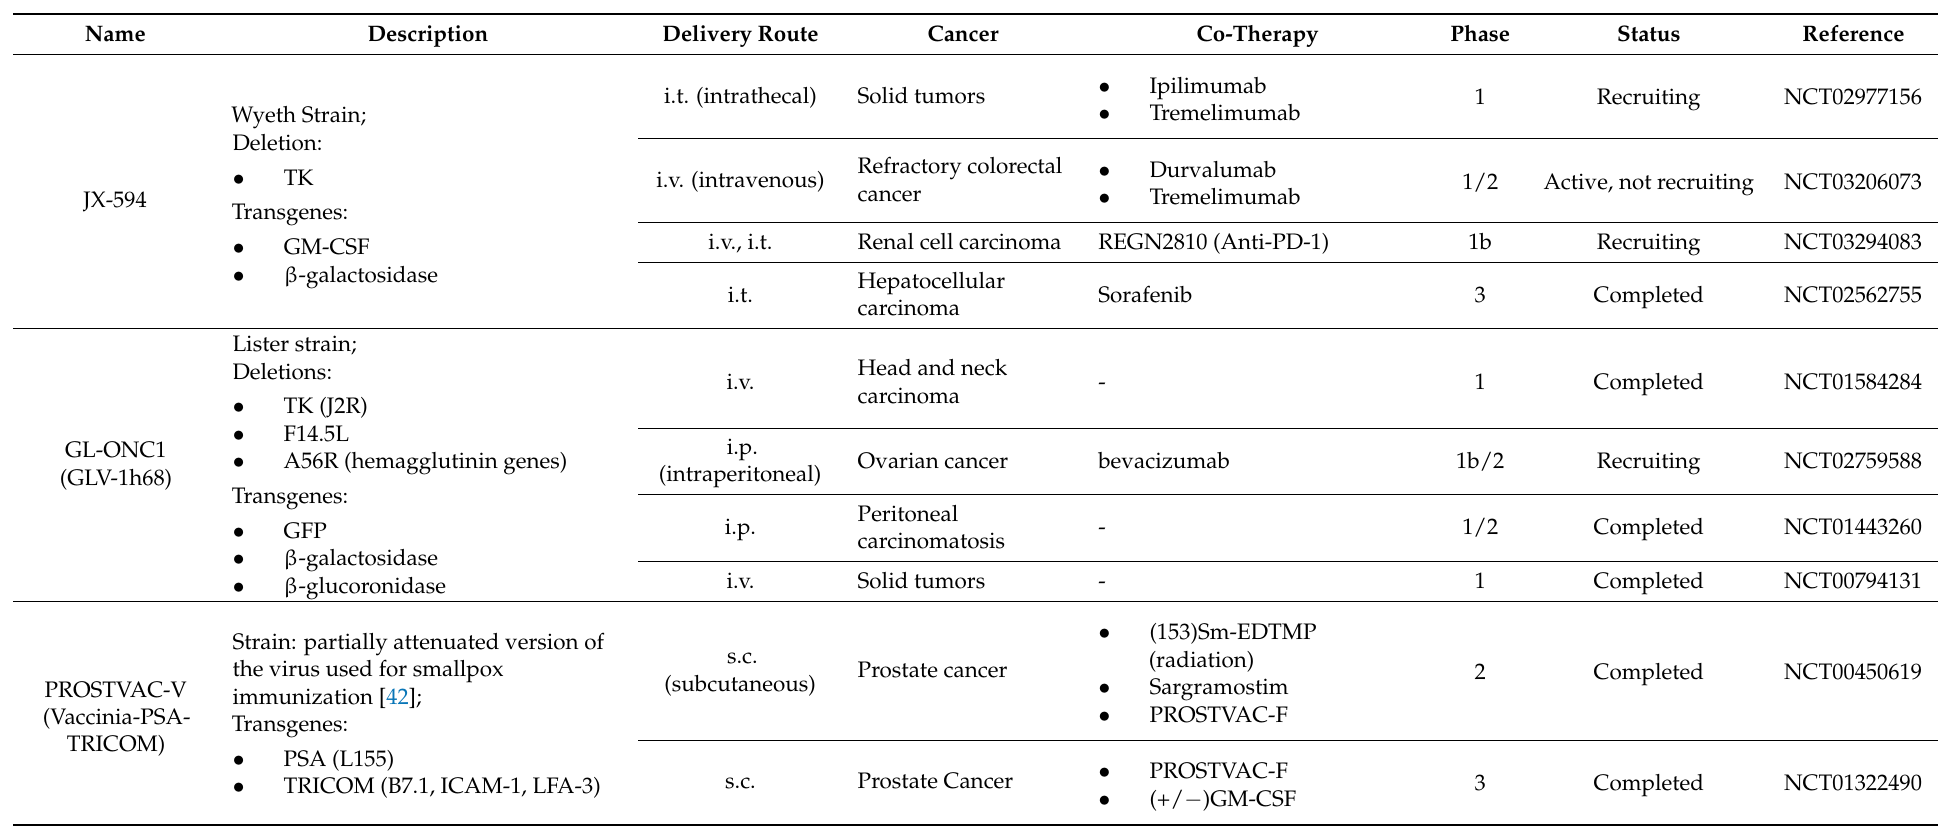
Table 1. Representative clinical studies of oncolytic